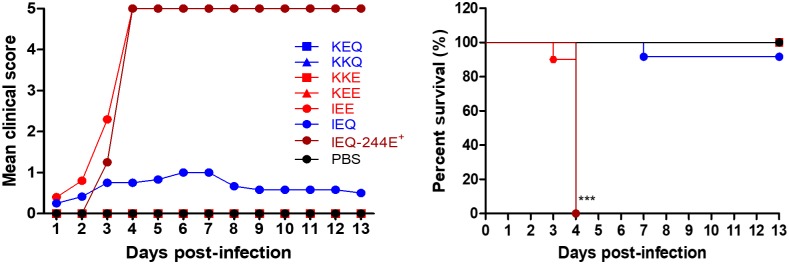
IEQ virulence was attenuated when inoculated intracerebrally.A dose of 1 × 105 PFU of each EV-A71 variant was administered intracerebrally into one-day old suckling mice. Clinical scores and percentage of survival over 13 days post-infection are shown. Significant differences between viral variants and WT are labelled as *** (P < 0.001).